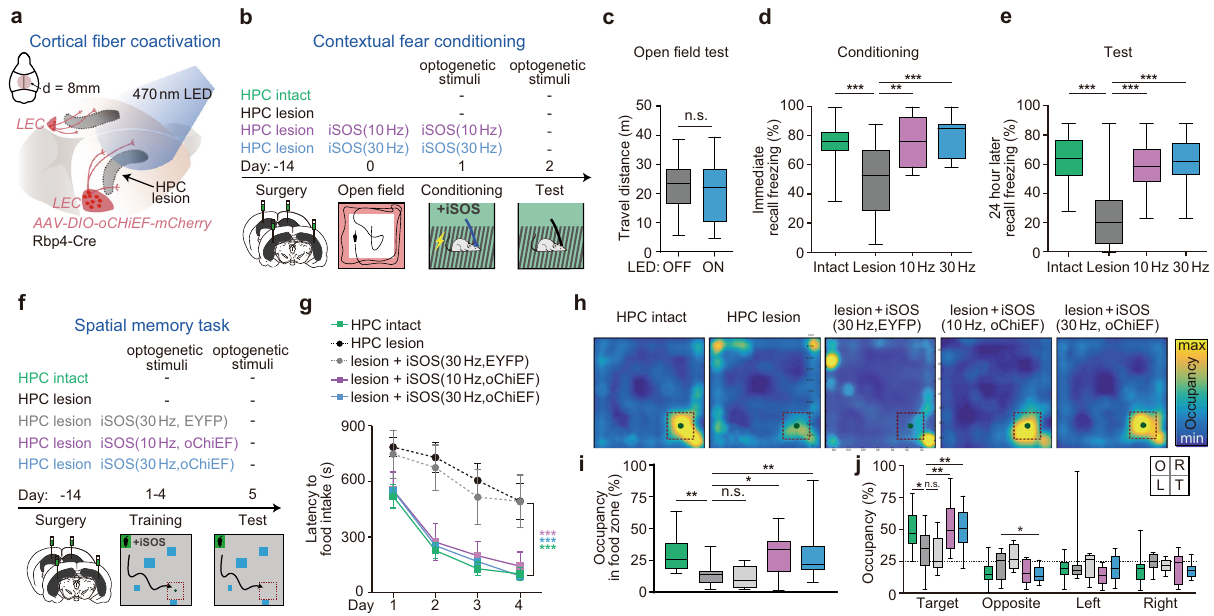
Fig. 3 Cortical application of iSOS rescued memory de fi cits in HPC-lesioned mice. a – e Arti fi cial iSOS in neocortex during training can rescue fear memory de fi cits in HPC-lesioned mice. a Scheme of the co-activation LEC fi ber during encoding. The iSOS were induced by LED on cortical surface to activate oCHiEF-expressing widespread axons from LEC L5. Activation of cortical fi bers but not LEC cell bodies is to avoid the unspeci fi c activation of circuits from LEC to other brain regions. b Flow of the behavioral experiment. All four groups of mice received contextual fear conditioning (CFC) training. Two groups of HPC-lesioned mice were given iSOS during training trials. Long-term memory was tested 24 h later without iSOS. HPC intact group means no HPC lesion, no iSOS applied and no virus infected. c Travel distance of open fi eld test upon given iSOS or not. (HPC-lesioned mice, N = 13, two-sided paired t -test , t (12) = 1.6 , P = 0.1449). d Immediate freezing after foot shock (N HPC intact = 15, N HPC lesion = 19, N iSOS-10Hz = 8; N iSOS-30Hz = 8; ANOVA, F (3, 46) = 9.1, P < 0.0001; Bonferroni post-hoc test, P Control vs. HPC-lesion = 0.0005, P iSOS-10Hz vs. HPC-lesion = 0.0035, P iSOS-30Hz vs. HPC-lesion = 0.0005). e Memory test in the conditioned context (same mice as d , ANOVA, F (3, 46) = 13.5, P < 0.0001; Bonferroni post-hoc test, P Control vs. HPC-lesion < 0.0001, P iSOS-10Hz vs. experiment. g Learning curves for the spatial memory task (mice number: N HPC-intact = 24, N HPC-lesion = 15, N iSOS (30Hz,EYFP) = 6, N iSOS (10Hz,oCHiEF) = 11;